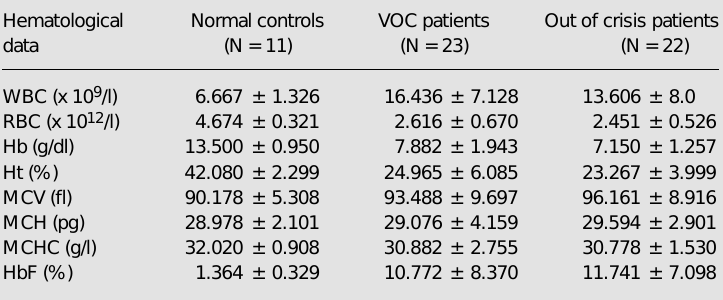
Figure 1. Scattergram show- ing ELISA analysis of the dis- tribution of interleukin 8 (IL- 8) levels in the serum of 23 patients in vaso-occlusive cri- sis (VOC), 22 out of crisis, and 11 normal healthy sub- jects. The IL-8 levels of the VOC group were supranor- mal, while the out of crisis and the normal healthy sub- ject groups had low IL-8 lev- els